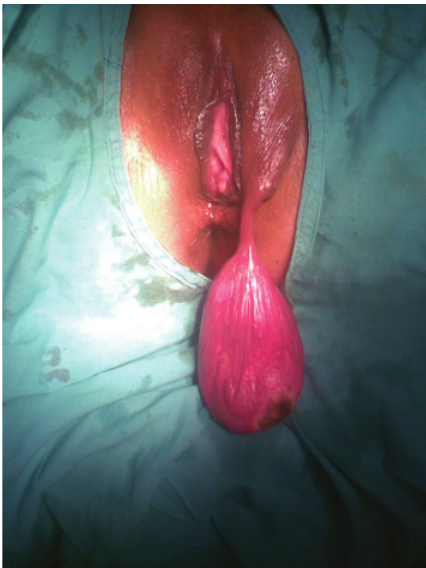
Figure 1: Large polypoidal growth from the left labia majora.